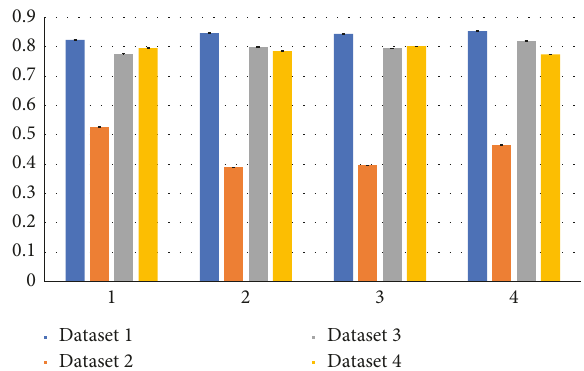
Figure 6: The mean accuracy results (with standard deviation) incorporating the mixup method with other methods in 10 runs based on the deep learning